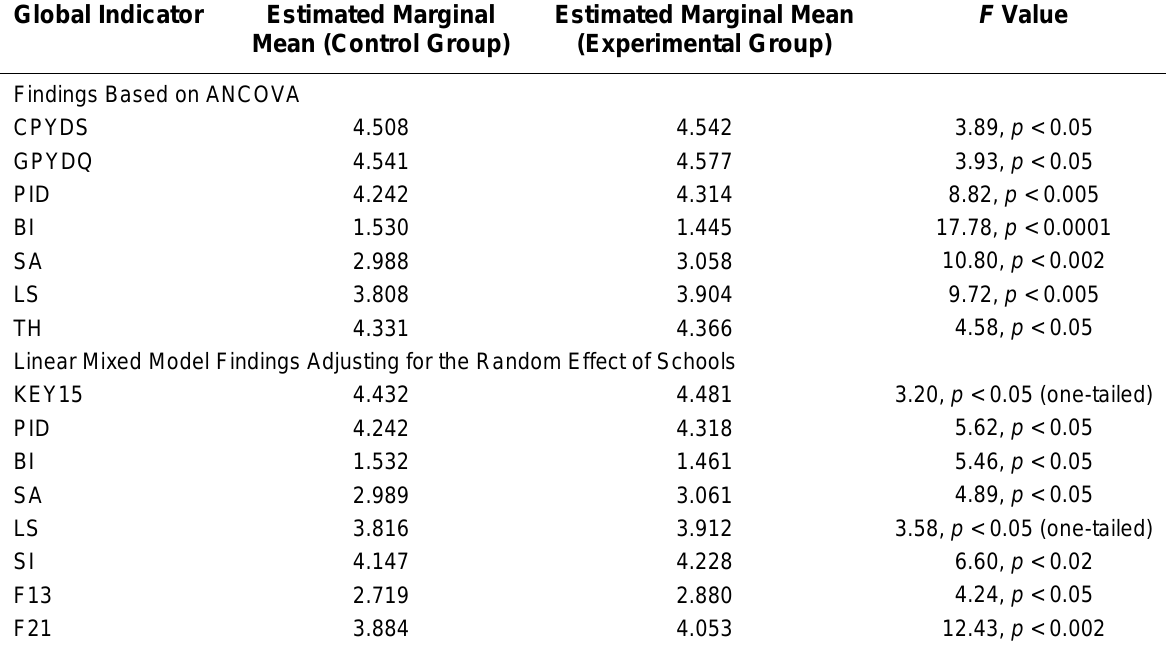
Differences between the Experimental Group (Joined the Tier 1 Program Only) and Control Group based on the Different Indicators Derived from the CPYDS Global Indicator